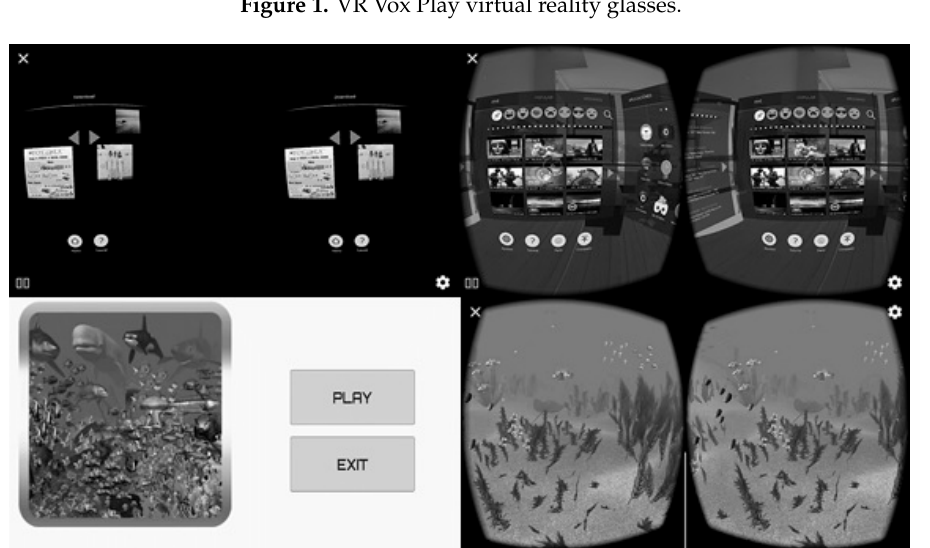
Figure 2. Virtual reality mobile applications: “Full Dive VR” on the top and “VR Ocean Aquarium 3D” on the bottom.